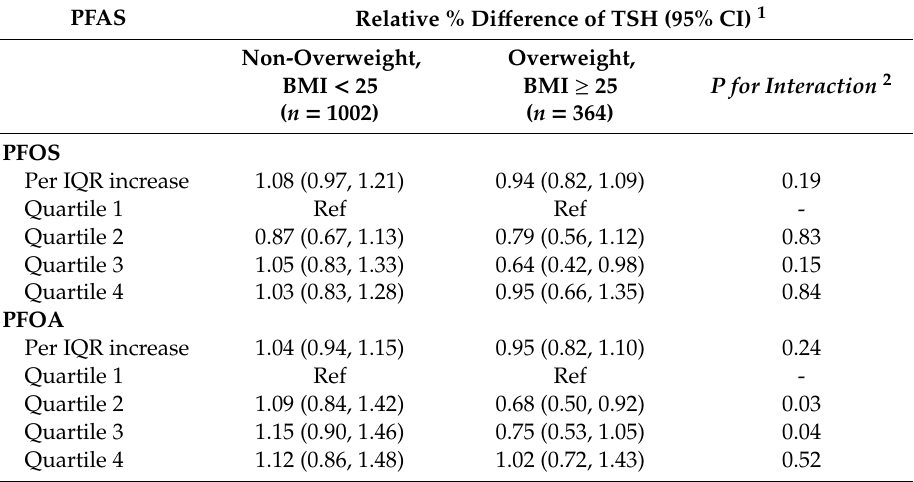
Table 2. Associations between plasma PFAS levels (ng / mL) and maternal thyroid hormone levels stratified by maternal overweight status indicated by body mass index